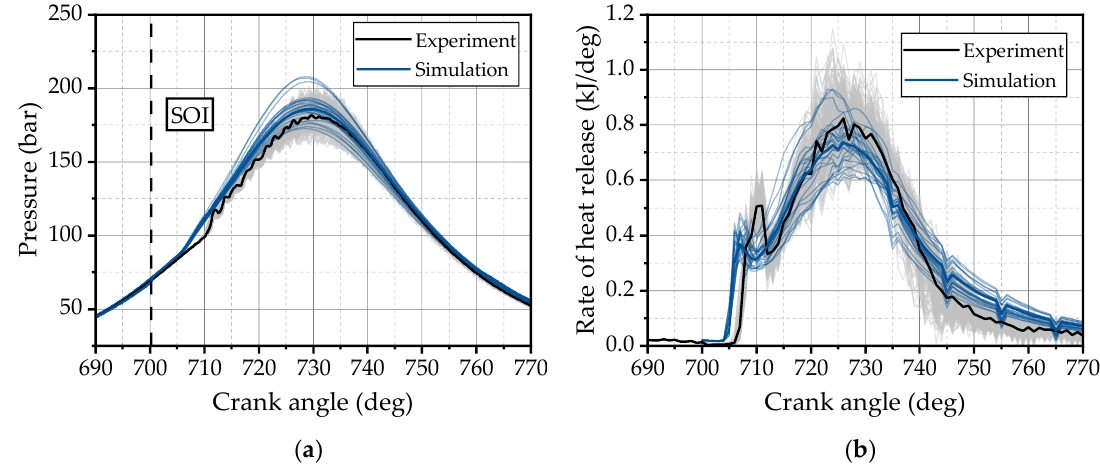
Figure 3. ( a ) Measured and simulated in-cylinder pressure traces with their corresponding averaged traces. ( b ) Rate of heat release calculated from experimental and simulated pressure traces.